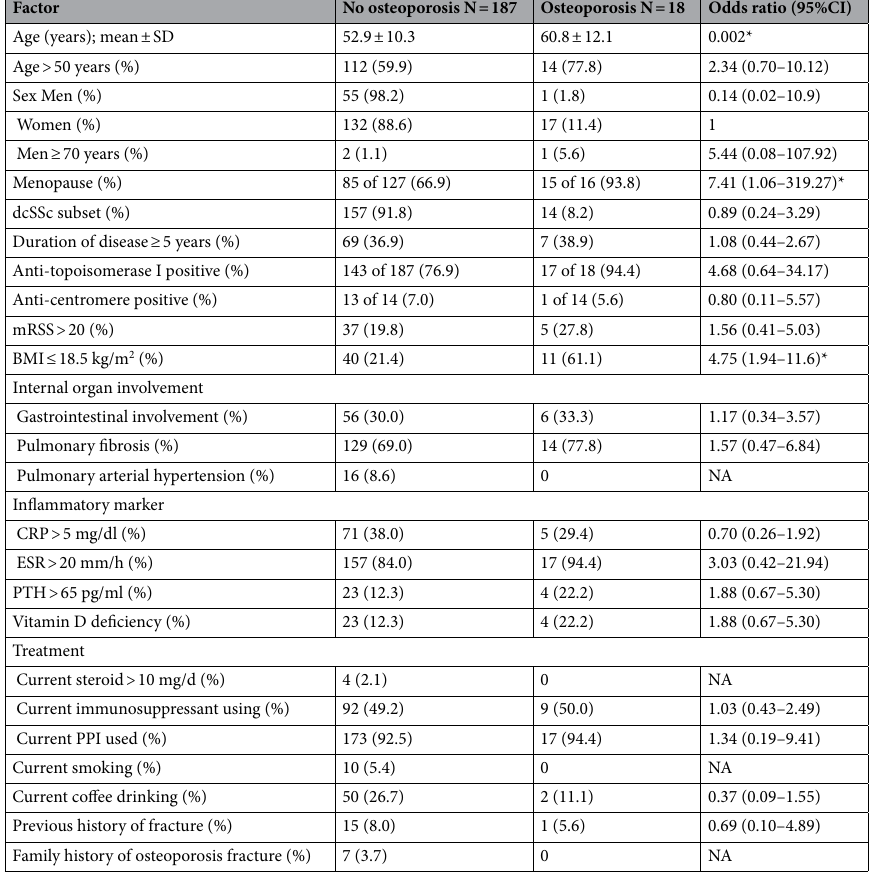
Table 3. Clinical factors associated with osteoporosis at the femoral neck. CI Confidence interval, dcSSc Diffuse cutaneous systemic sclerosis, mRSS Modified Rodnan skin score, CRP C-reactive protein,